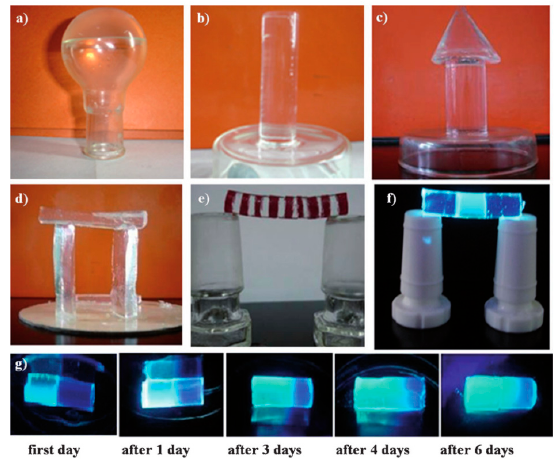
Figure 4. Vidyasagar et al. organogels combine glass-like optical properties with desirable physical